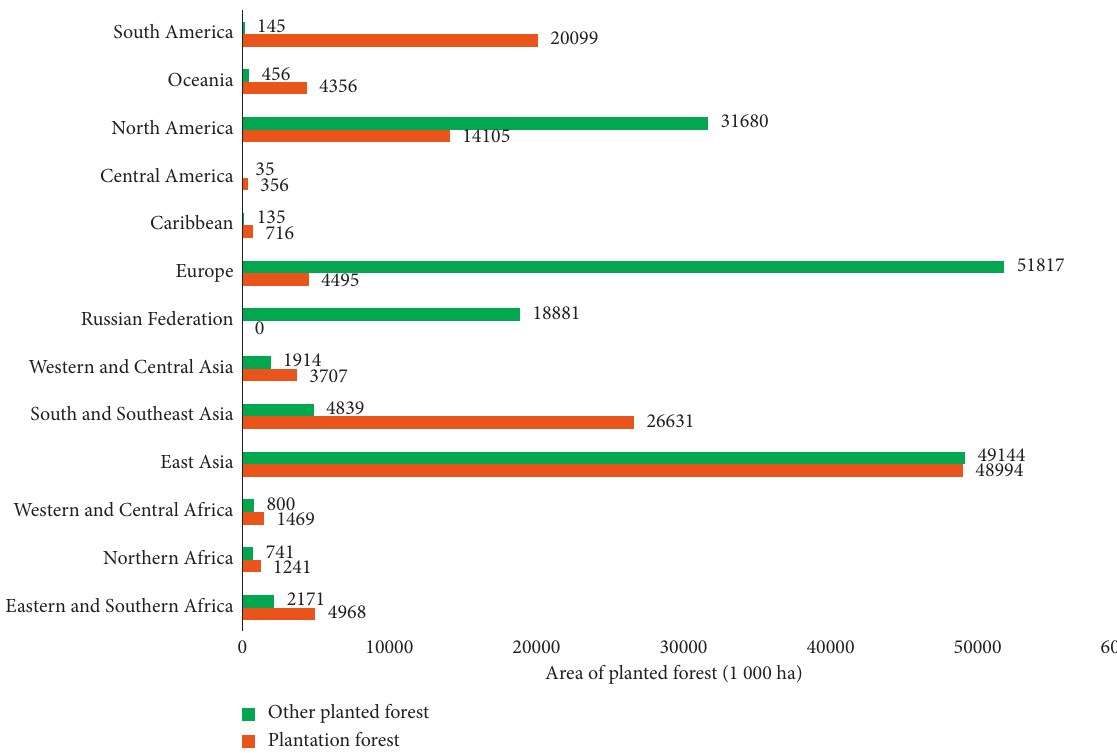
Figure 2: Area of plantation forest and other planted forests, by region and subregion, 2020 [1].